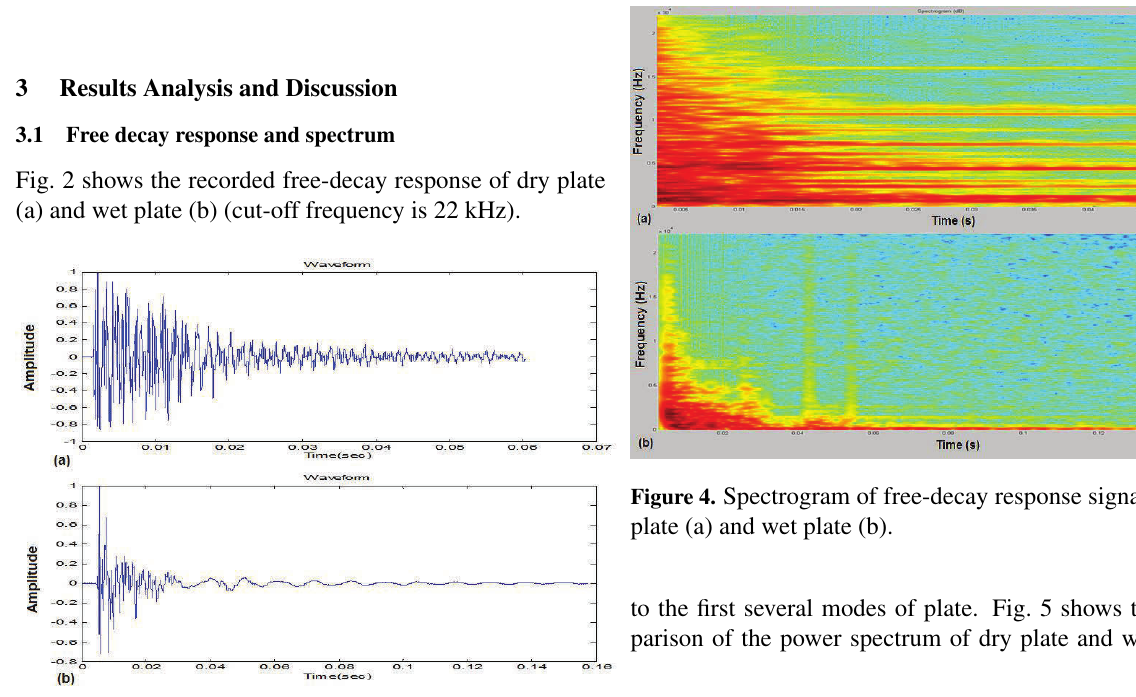
Figure 1. Schematic of test setup.